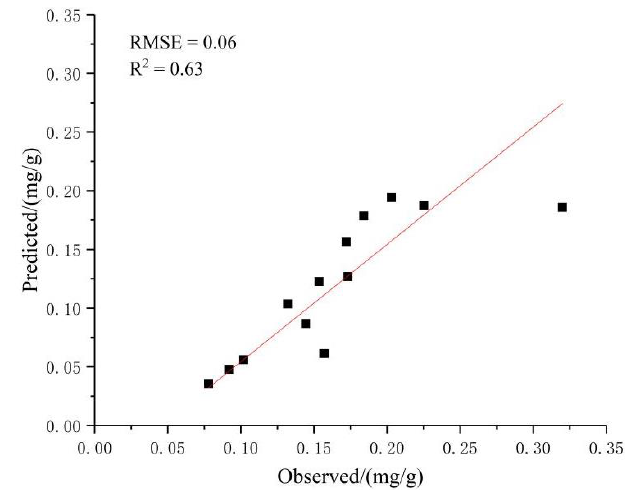
Figure 3. Relationships between observed and predicted values of chlorophyll content in the peri- carp of fragrant pears by the error backpropagation neural network (BPNN) model.